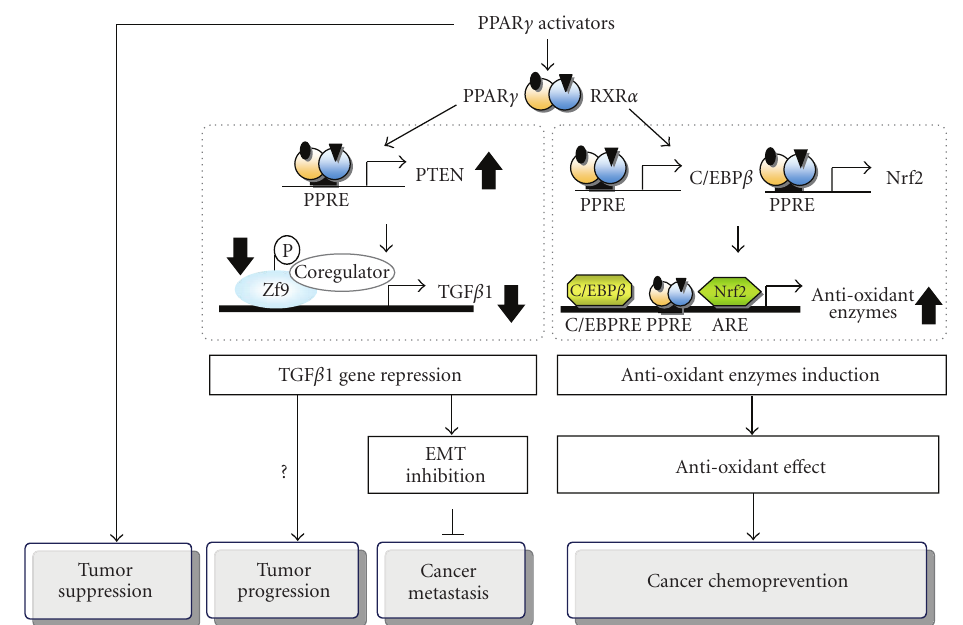
Figure 2: A schematic presentation of the multiple pathways regulated by PPAR γ for tumor suppression, progression, inhibition of metastasis, and cancer chemoprevention.